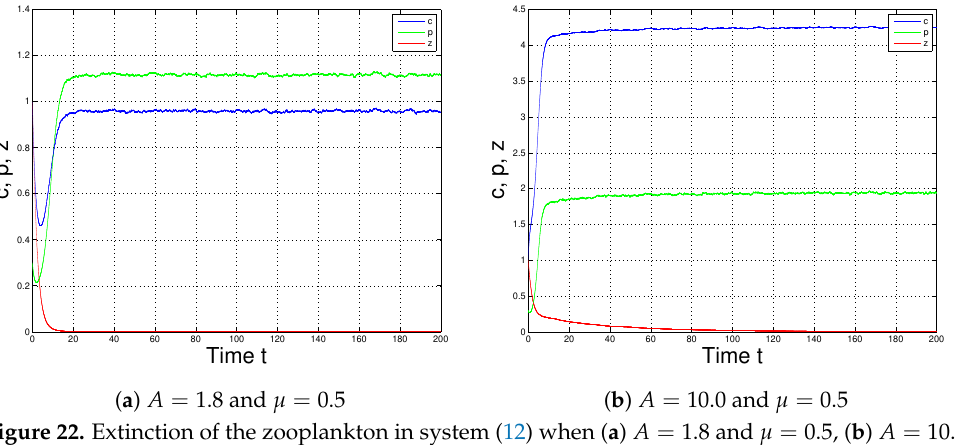
Figure 22. Extinction of the zooplankton in system (12) when ( a ) A = 1.8 and µ = 0.5, ( b ) A = 10.0 and µ = 0.5 and remaining parameters are chosen from set (13).